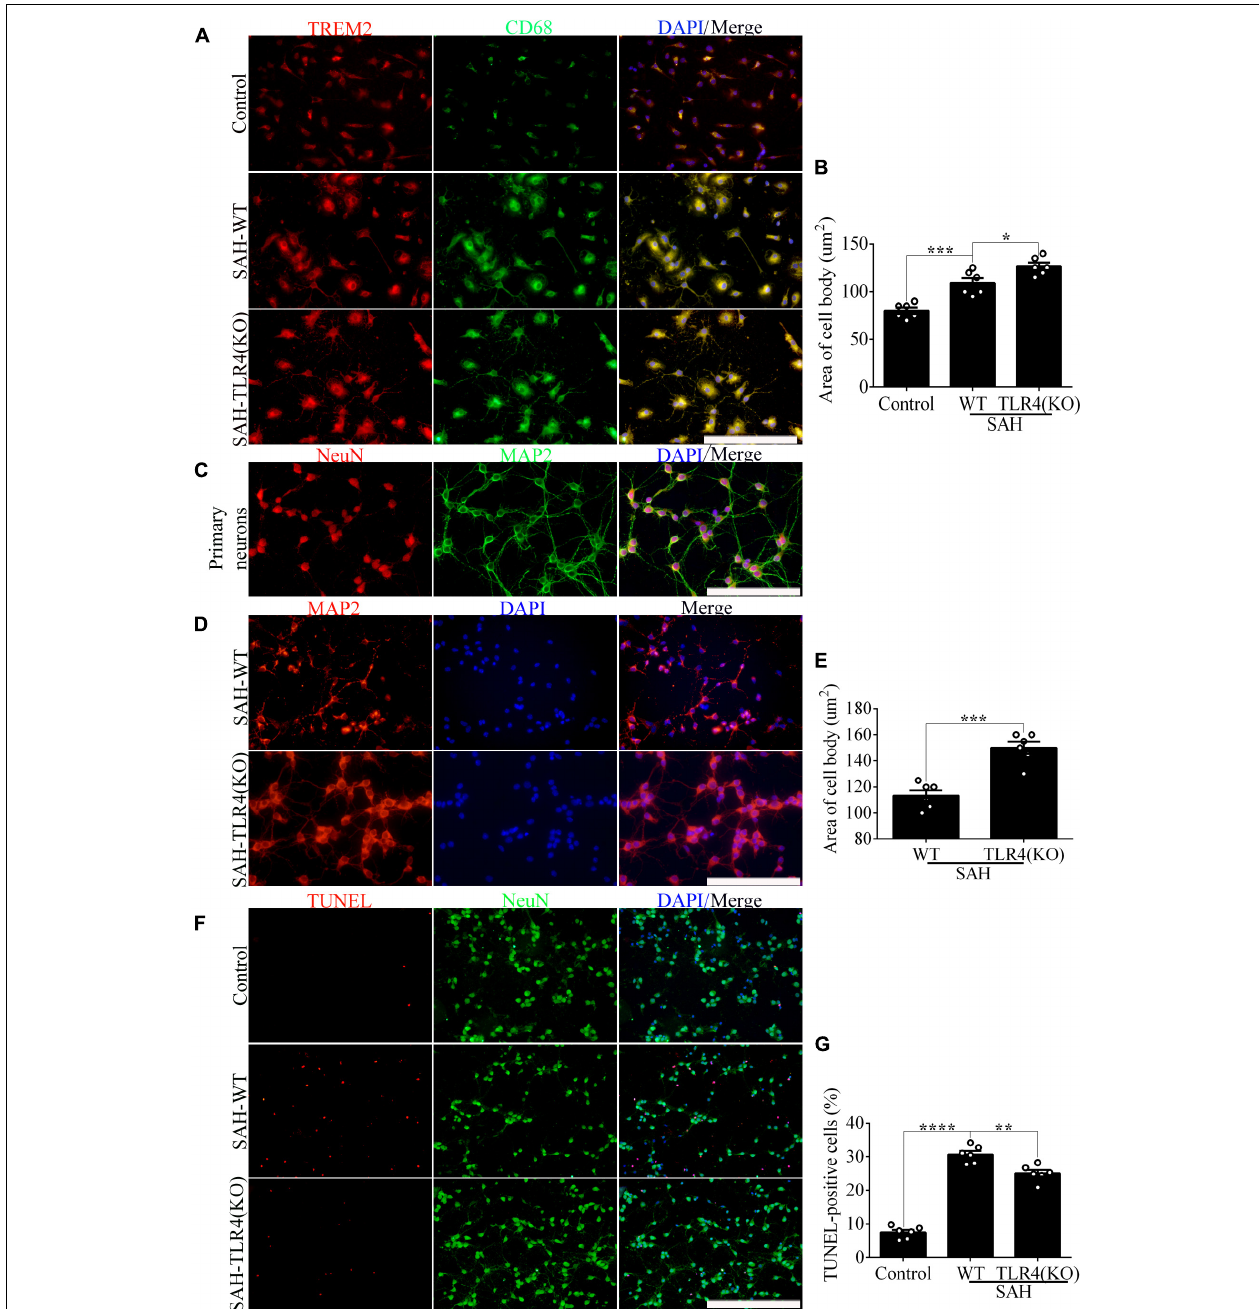
FIGURE 5 | Microglial Toll-like receptor 4 ( TLR4 ) deficiency ameliorates the neuronal damage in the coculture system after subarachnoid hemorrhage (SAH). (A,B) The double immunofluorescence staining of triggering receptor expressed on myeloid cells 2 ( TREM2 )/CD68 was detected and quantified in microglial cells. (C) Double immunofluorescence staining showed the cell purity of primary neurons. (D–G) The MAP2 staining terminal deoxynucleotidyl transferase-mediated dUTP nick end-labeling (TUNEL) labeling was quantified to reveal the regulation of microglial TLR4 / TREM2 on primary neurons. These data are shown as mean ± SEM ( *p < 0.05, **p < 0.01, *** p < 0.001, **** p < 0.001; A,C,D , scale bar = 25 µ m; F , scale bar = 50 µ